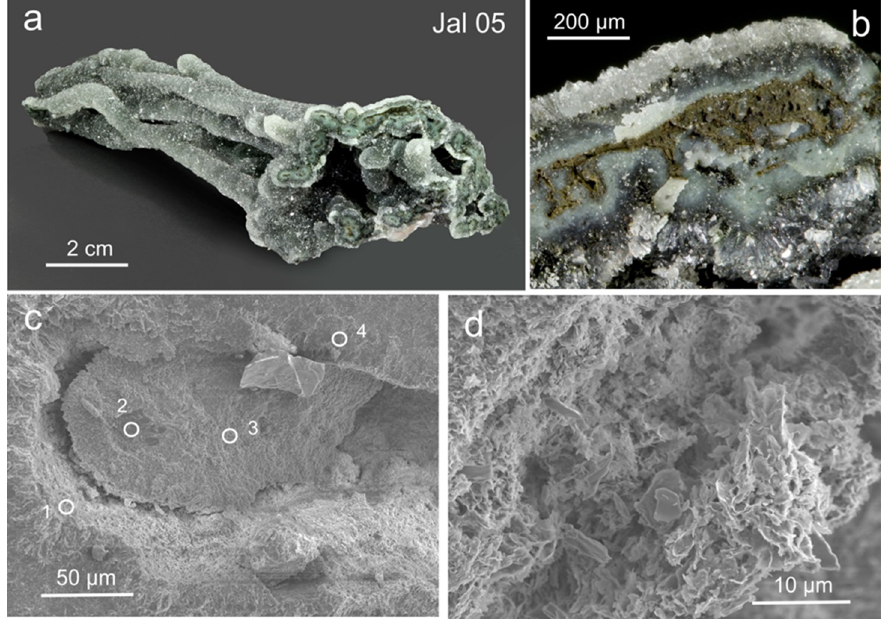
Figure 13. Morphological and textural features of sample Jal 05 from secondary mineralization in cavities of flood basalt of Jalgaon/Savda, India: ( a ) large, multi-filamentous chalcedony aggregate with greenish, zoned core; ( b ) details of the different concentric mineralization layers with fine-grained greenish-brown minerals in the central filamentous cores; ( c ) cross-section (SEM-SE micrograph) of the central part of an aggregate with a filamentous core and a small empty interspace to the following mineralization sequence (the numbers relate to analytical spots of EDX measurements, see Table S3); ( d ) close-up of (c) illustrating the fine-grained, irregular mineralization of the surface of the filamentous core.